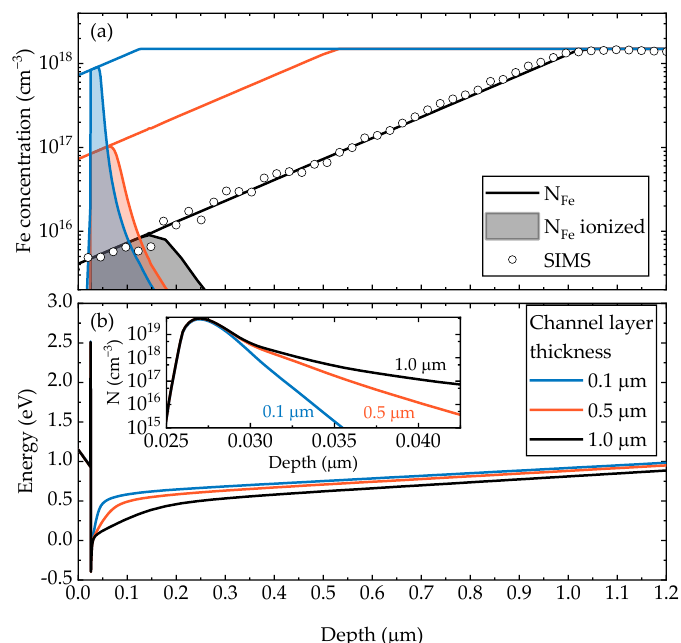
Figure 3. The concentration profiles of total and ionized Fe impurities ( a ) and conduction band energies ( b ) for the structures with 0.1, 0.5 and 1.0 μm channel layer. Symbols in ( a ) denote Fe impurity profile measured by SIMS. The inset shows the calculated electron concentrations in the corresponding structures.